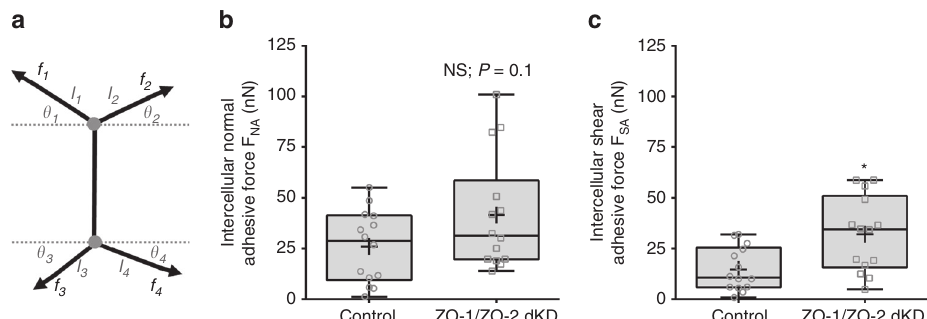
Fig. 7 Intercellular adhesion forces level in ZO-1/ZO-2 dKD polarized monolayers are regulated and maintained close to controls. a Model of the arrangement of intercellular actomyosin contractile pulling forces and intercellular adhesion forces at a cell – cell contact. The actomyosin pulling forces at tricellular juctions f i depends on the level of epithelial tension and the length of the cell edge. The intercellular adhesion forces maintain epithelium cohesiveness and depend on actomyosin the level of the pulling forces ( f i ), cell edge length ( l i ), and cell edge angle ( θ i ). b Intercellular normal and c shear adhesive forces determined on control and ZO-1/ZO-2 dKD polarized epithelial. * indicates signi fi cant difference in comparison with control P < 0.05 (unpaired two-tailed Student ’ s t -test with Welch ’ s correction); NS nonsigni fi cant differences in comparison with control P > 0.05(unpaired two-tailed Student ’ s t -test with Welch ’ s correction); number of measurements pooled for each condition, n =